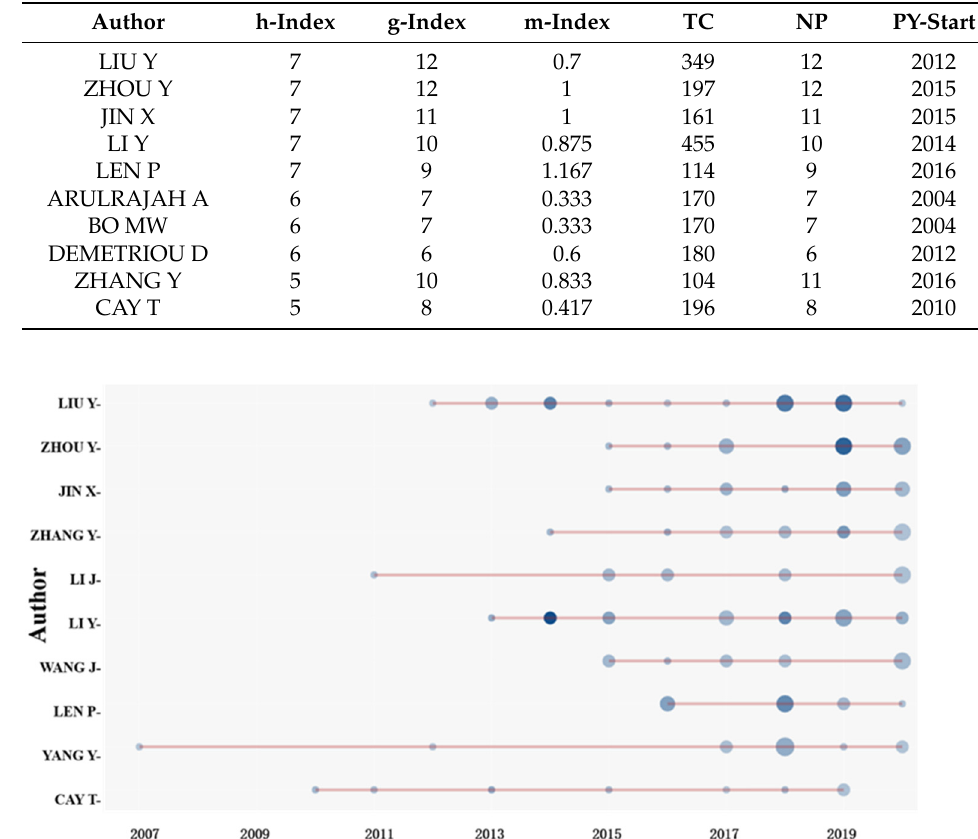
Figure 5. Authors’ production over time in the field of land consolidation.